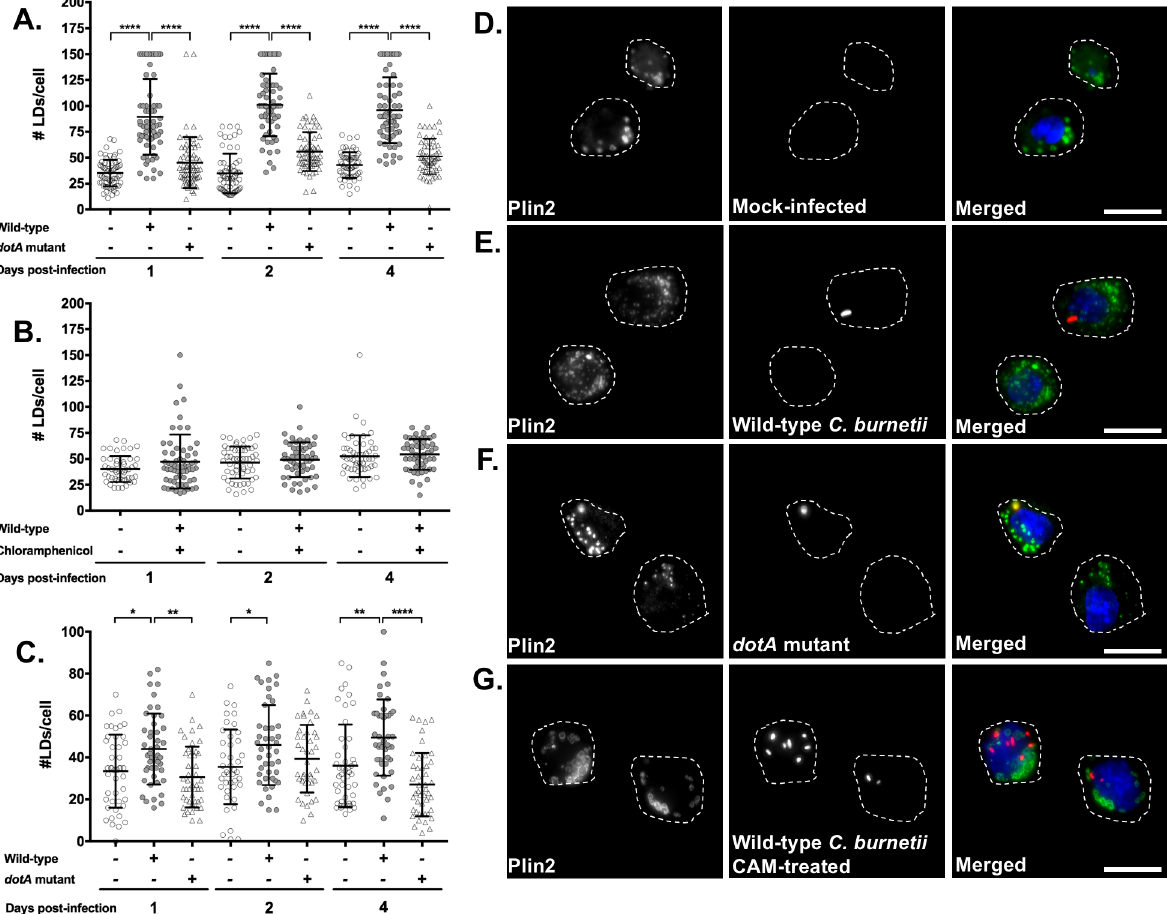
Fig 2. C. burnetii infection leads to host cell LD accumulation and is dependent on bacterial protein synthesis and the T4BSS. Macrophages were infected with C . burnetii and at different times post-infection, cells were stained for PLIN2 (LDs; green), C . burnetii (red) and nucleus (blue). LD number per cell were quantitated by fluorescence microscopy. A) LD numbers in wild-type C . burnetii and dotA mutant- infected MH-S macrophages. B) LD numbers in MH-S macrophages either uninfected, untreated or infected with wild-type C . burnetii and treated